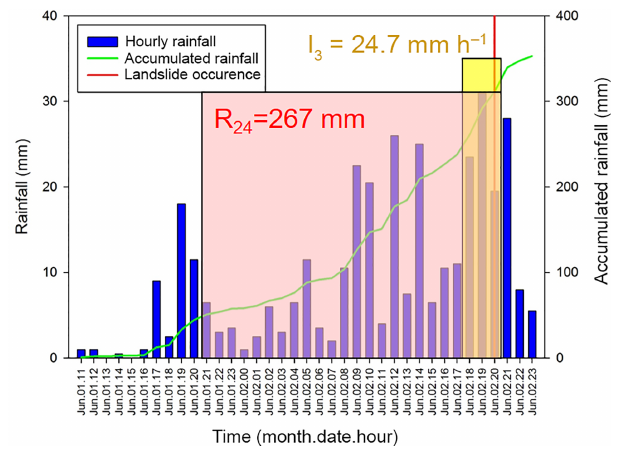
Figure 4. Establishment of I 3 – R 24 rainfall thresholds for shallow landslides. The best fit line was derived by least square method, and the ratio of a and b was used as the ratio of the semi-major axis and semi-minor axis in the ellipse threshold